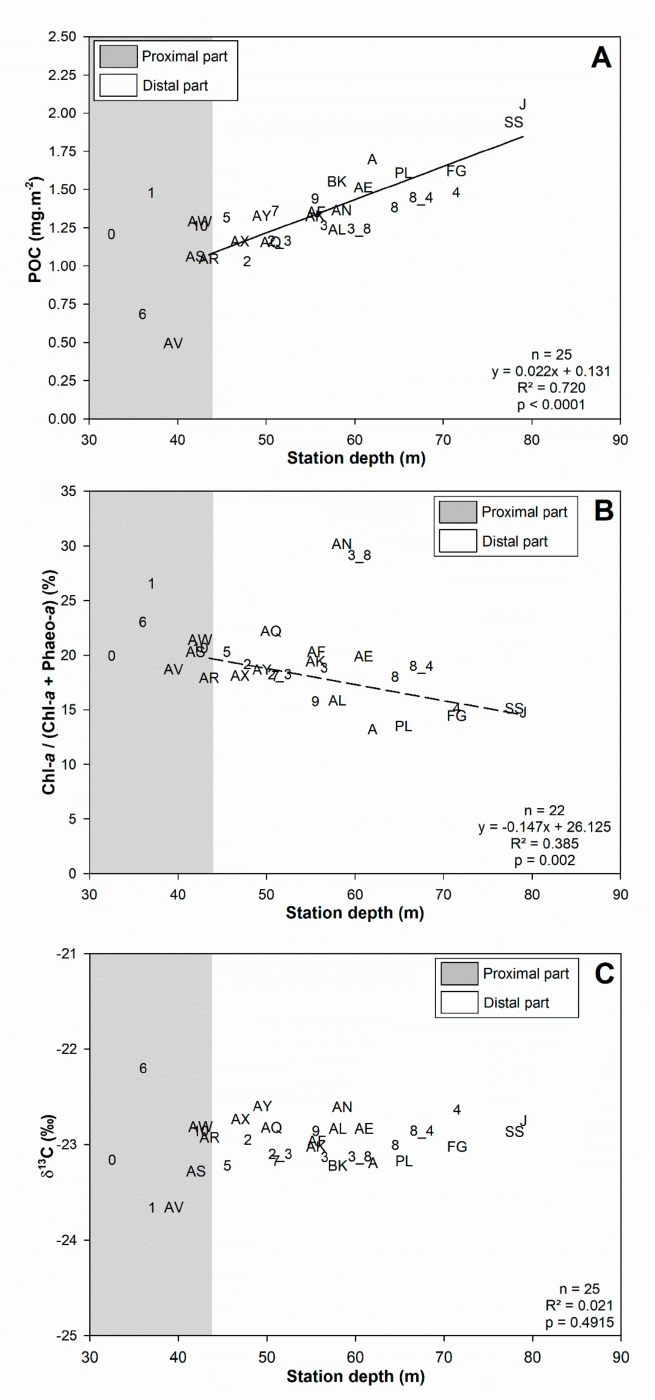
Figure 3. Relationships between station depth and main surface sediment characteristics: Particulate Organic Carbon concentration (POC; ( A )); Chl- a /(Chl- a +Phaeo- a ) ratio ( B ) and δ 13 C ( C ). Gray areas represent the proximal part (z < 42.5 m) of the WGMP. Station codes are the same as in Figure 1 and Table A1. The continuous line represents the linear regression linking station depth and POC concentration within the distal part of the WGMP, and the dotted line represents the linear regression linking station depth and Chl- a /(Chl- a +Phaeo- a ) ratio within the distal part of the WGMP (excluding stations AN and